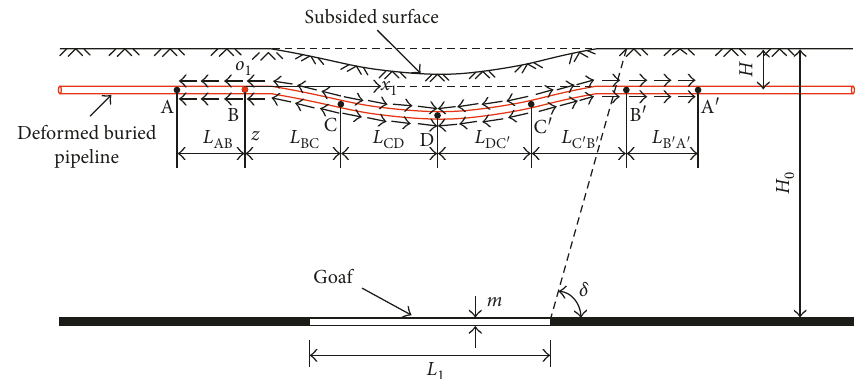
Figure 7: Distribution of frictional force along the pipeline in the subsidence